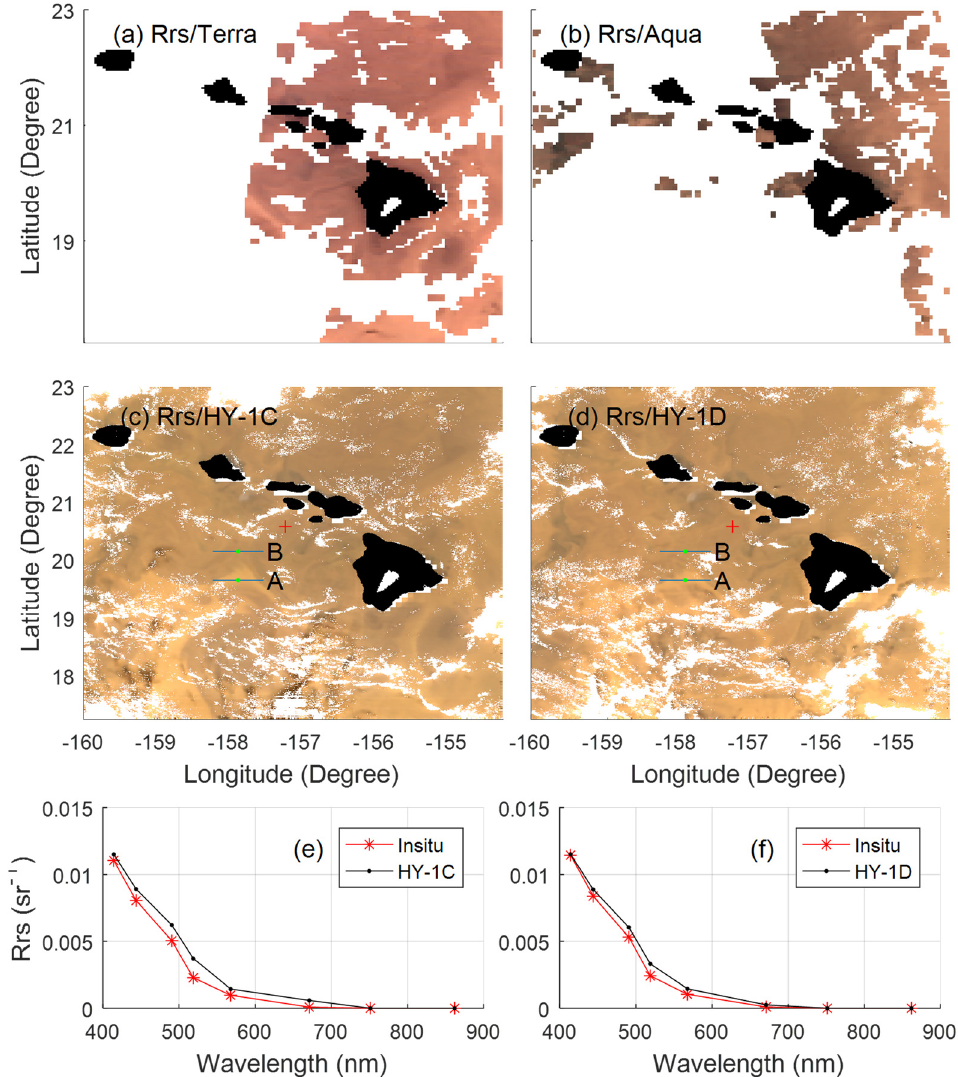
Figure 1. The composite R rs images of Bands 1–3 from the MODIS on 6 October 2020 with Terra ( a ) and Aqua ( b ); those from COCTS on HY-1C ( c ) and HY-1D ( d ), where the red cross marks the position of the MOBY site and two blue lines (A and B) are used to demonstrate the structures of spectra along the lines in Figures 12 and 13; the spectral R rs comparison of the in situ measurements at the MOBY site (red line) and the satellite-retrieved images (green line) for HY-1C ( e ) and HY-1D ( f ).